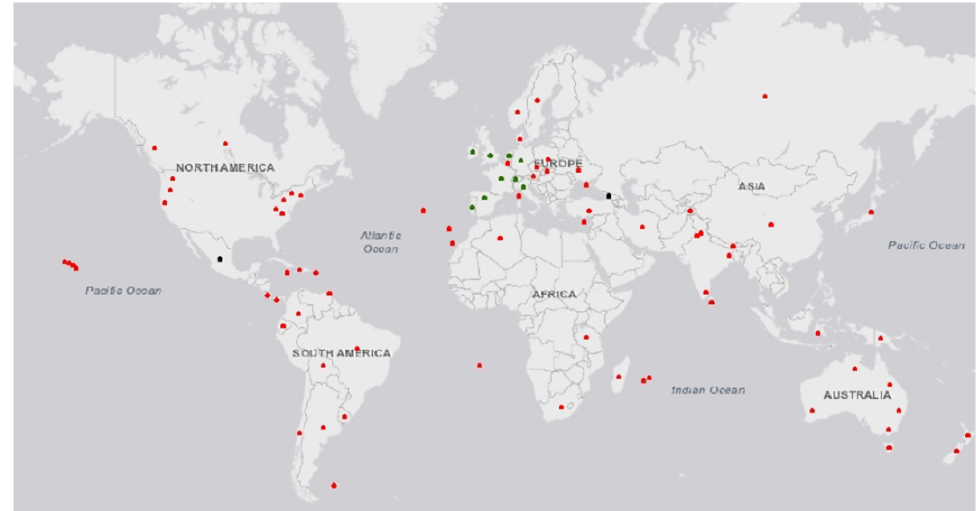
Figure 1. Reported global distribution of gorse. Green—natural distribution, red—introduced populations, black—unknown (presumed introduced). Created in ArcMap 10.5 from national and international databases (after [6]).